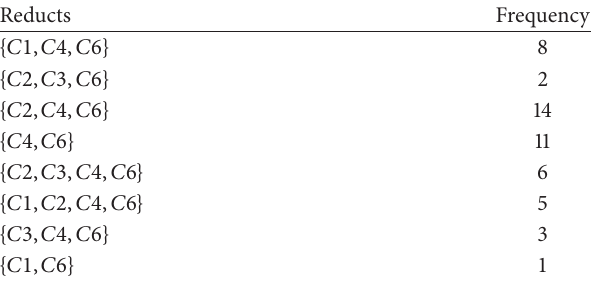
Table 4: Reducts and their